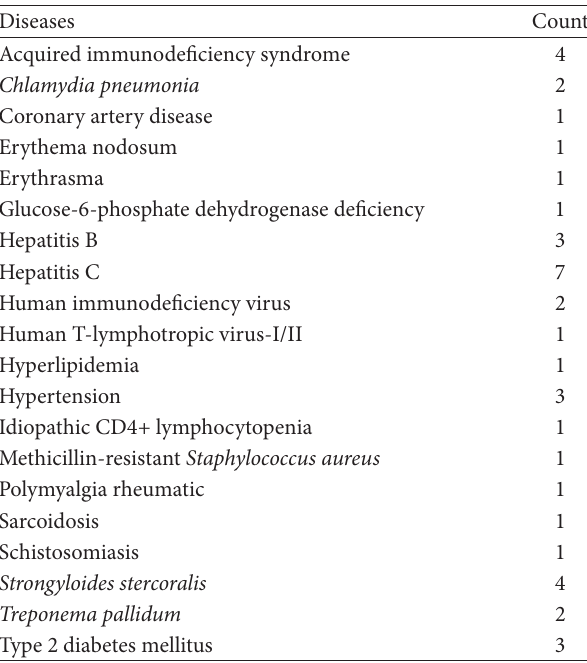
Table 1: Patient demographics. Table 2: Comorbid conditions.